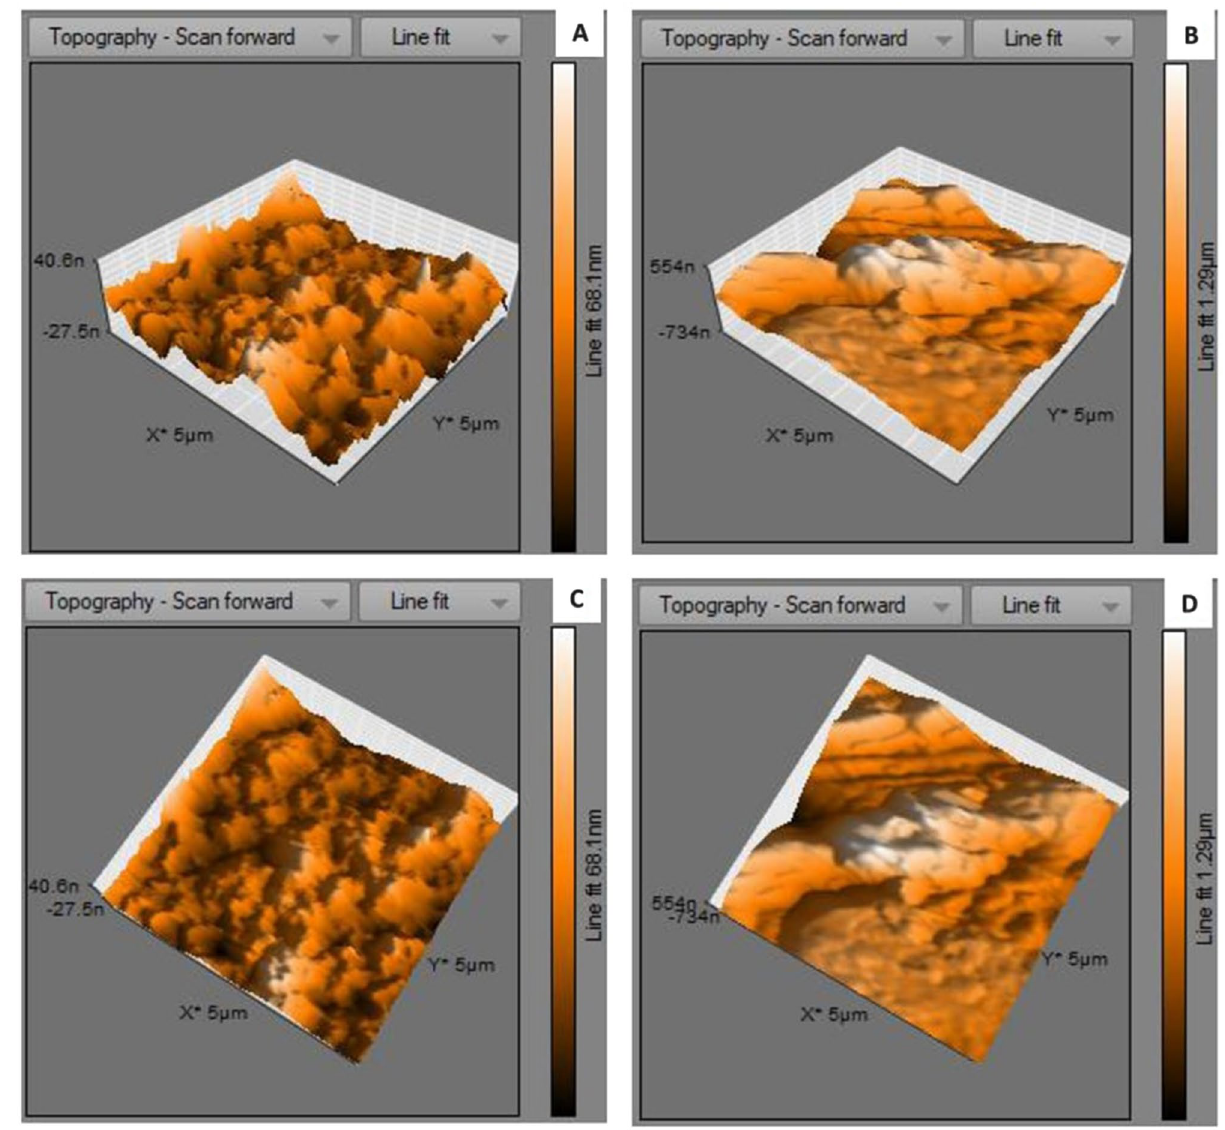
Figure 27. ( A ) Three-dimensional view of control (untreated) LDPE sheet of 5 µm 2 area; ( B ) Three- dimensional view of U. africanum treated LDPE sheet; ( C ) Topographical view of control (untreated) LDPE sheet; ( D ) Topographical view of U. africanum treated LDPE sheet with erosions on its